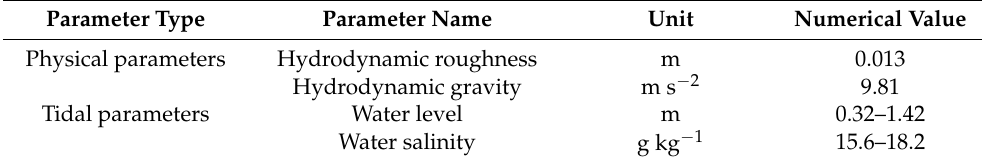
Table 2. Dam and gate valve settings in different